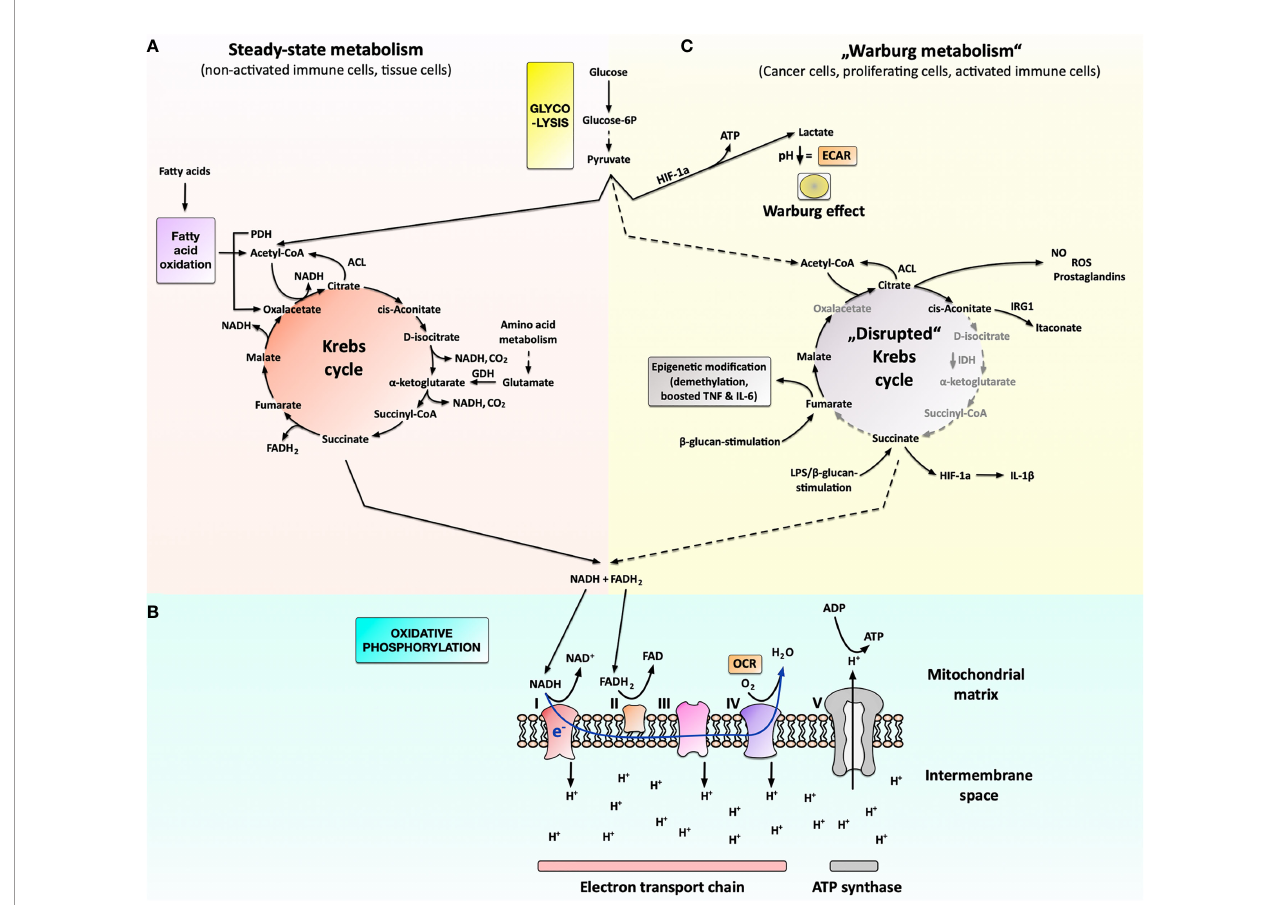
FIGURE 1 | Cellular metabolism under steady-state conditions and metabolic changes associated with cancer cells, proliferating cells, or activated immune cells. Under steady-state conditions (A) , cells take up glucose from their medium and metabolize it to pyruvate in a cytoplasmic process called glycolysis. Pyruvate is subsequently imported into the mitochondria, where it is used in the Krebs cycle to generate the reduction equivalents NADH and FADH 2 . Besides glucose, the Krebs cycle can also be replenished by acetyl-CoA derived from fatty acid oxidation (FAO) or glutamate derived from amino acid metabolism. NADH and FADH 2 generated in the Krebs cycle are then used in the oxidative phosphorylation to generate energy (B) . Here oxygen is used as the terminal electron acceptor in the electron transport chain (consisting of complexes I through IV) to generate a proton gradient over the inner mitochondrial membrane (measured as oxygen consumption rate (OCR)). This proton gradient drives the generation of ATP via the ATP-synthase complex. Under certain conditions, cancer cells, strongly proliferating cells, or activated immune cells switch their metabolism to predominantly produce lactate from glucose instead of fully oxidizing glucose into CO 2 in the mitochondrion (C) . The produced lactate is secreted from the cell, leading to an extracellular pH decrease that can be measured as extracellular acidi fi cation rate (ECAR). Moreover, the lack of pyruvate results in a “ disrupted ” Krebs cycle, which the activated immune cells use to generate important biosynthetic intermediates needed for immune cell effector function such as prostaglandins, NO, ROS, or itaconate. Additionally, fumarate and acetyl-CoA (generated, for example, from citrate via the ATP-citrate lyase, ACL) can be used for epigenetic modi fi cation. For more information see main text. FAO, fatty acid oxidation; ROS, reactive oxygen species; NO, nitric oxide; FAS, fatty acid synthesis; PDH, pyruvate dehydrogenase; ACL, ATP-citrate lyase; GDH, glutamate dehydrogenase; IDH, isocitrate dehydrogenase; IRG1, immune-responsive gene 1; HIF-1a, hypoxia-inducible factor 1a; OCR, oxygen consumption rate; ECAR, extracellular acidi fi cation rate; I to IV, complex I to